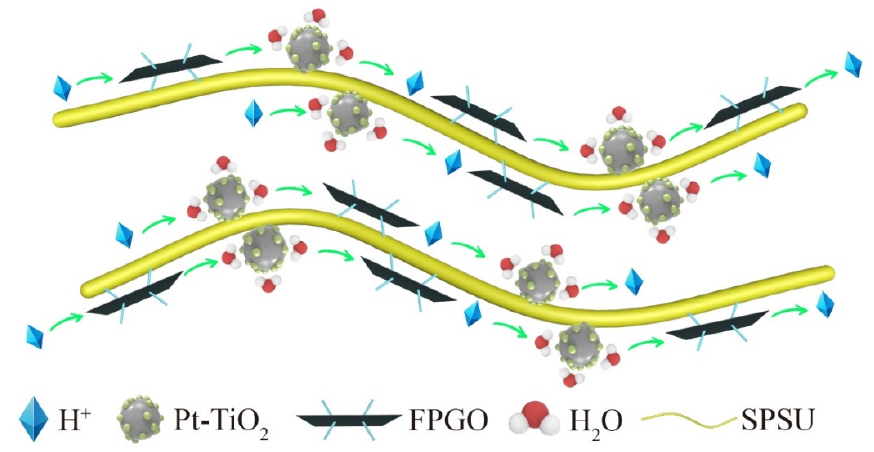
Figure 8. Diagram of proton conductivity mechanism in the nanocomposite PEM. Figure 9 indicates the operating time-dependent proton conductivity of the primary SPSU membrane, the cross-linked PEM and the nanocomposite PEMs at 60 ◦ C and room humidity (RH) of 39%. The membrane holder was suddenly heated to 60 ◦ C while